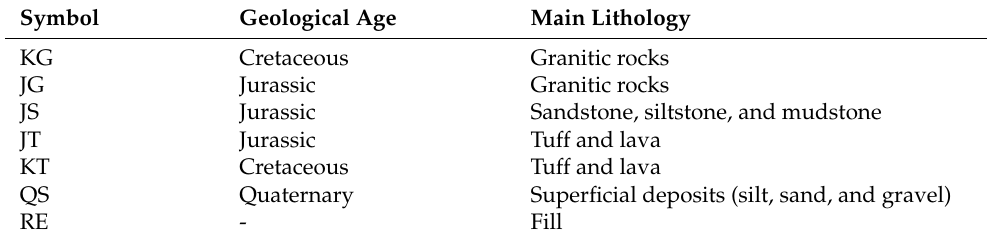
Table A2. Information of the lithology in Lantau